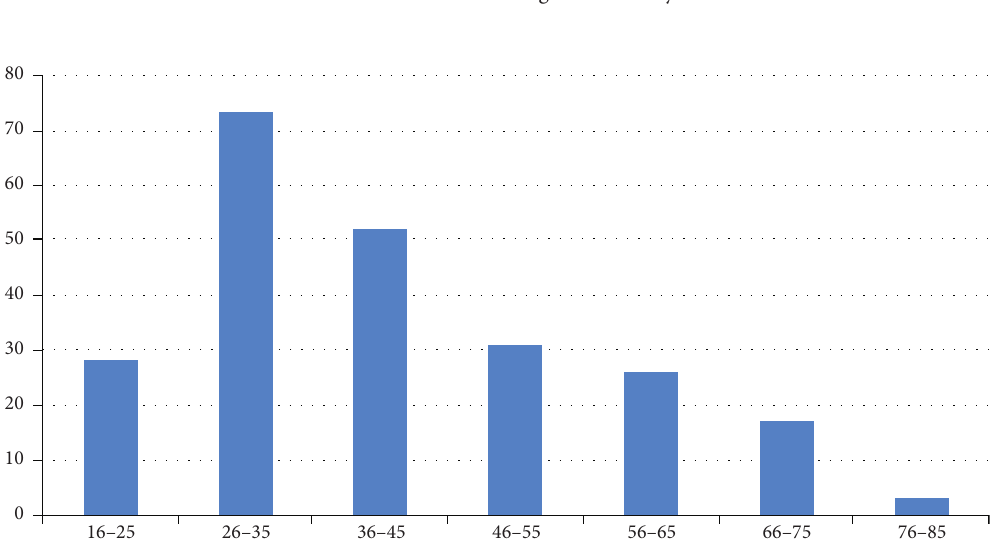
Figure 5: Overall findings of the study.